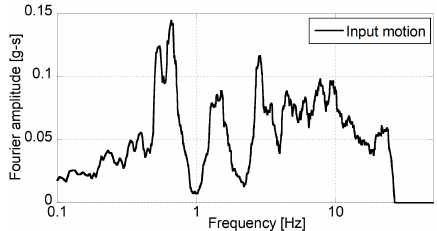
Figure 16. Frequency content of the input ground